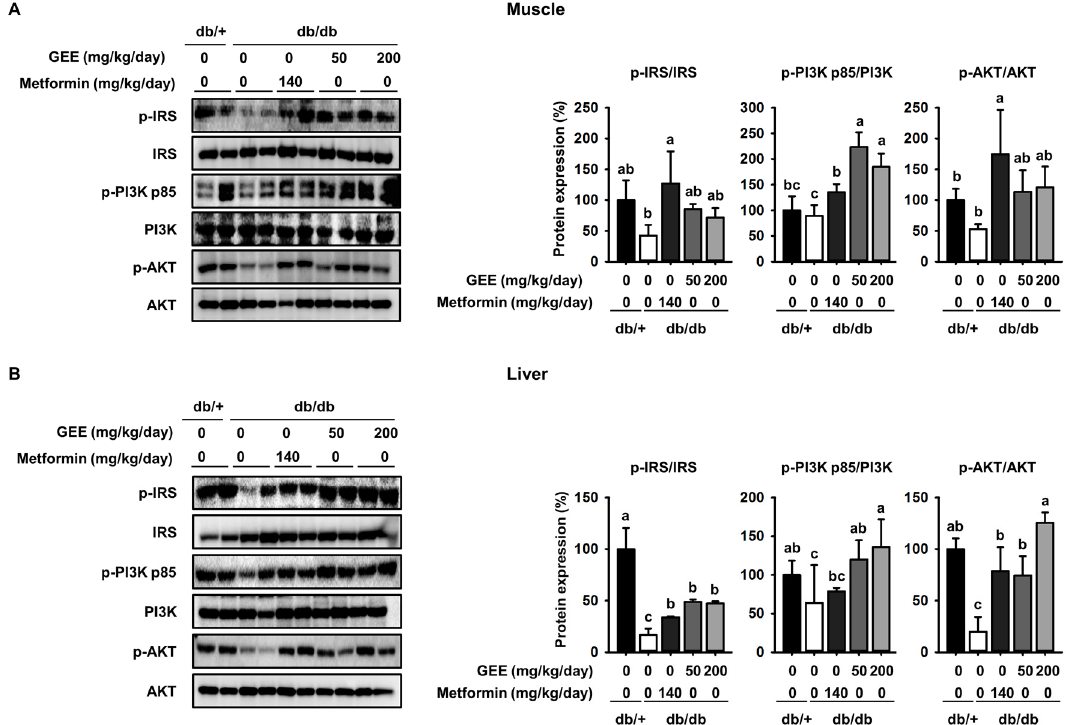
Figure 4. GEE increases glucose uptake via the phosphoinositide 3-kinase (PI3K)/Akt pathway in db/db mice. Five-week-old mice were administered with or without GEE (50 and 200 mg/kg/day) for five weeks. phospho-IRS-1, phospho-PI3K, and phospho-Akt were determined by western blotting in the skeletal muscle ( A ) and liver ( B ). Phosphorylation of each intermediate was quantified after